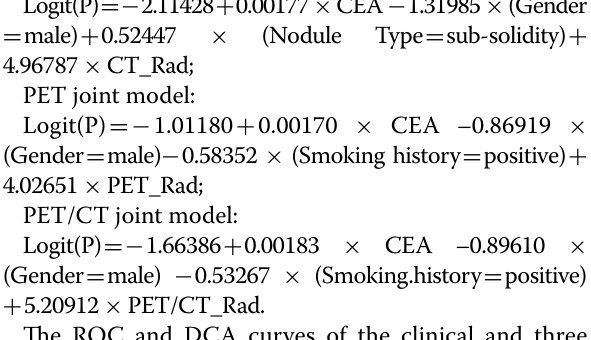
Table 2 Comparison of the predictive performance of clinical model, radiomics models, and joint models